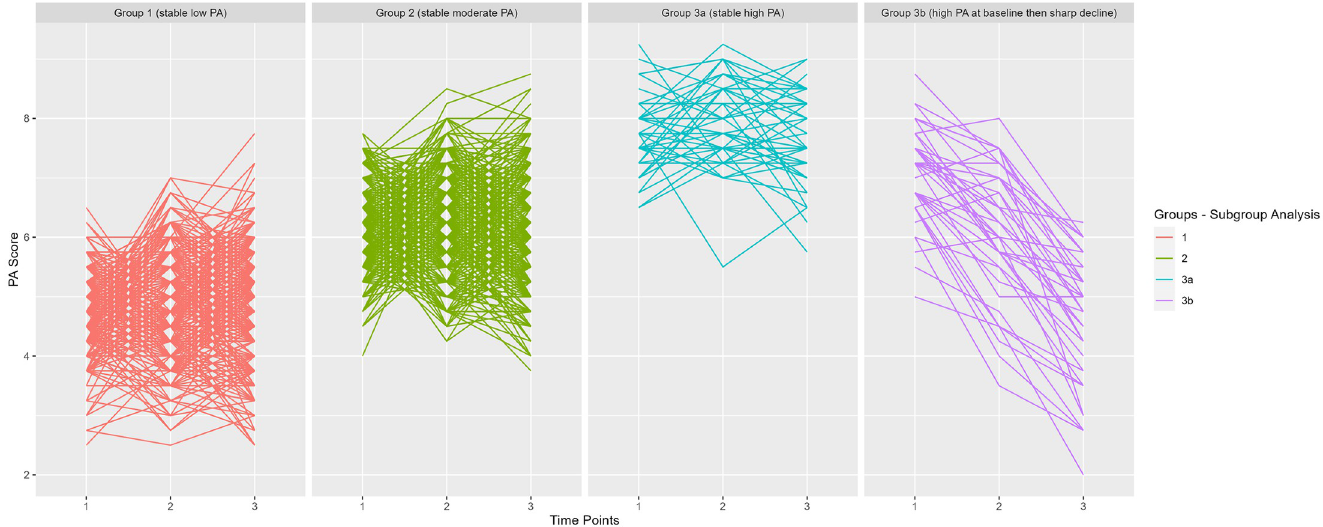
Fig 4. Regression lines of the participants in each trajectory based on the Physical Activity (PA) measurements of 1041 CARLA participants at 3 time points in a subgroup analysis where Group 3 is divided into 2 Groups: 3a and 3b.